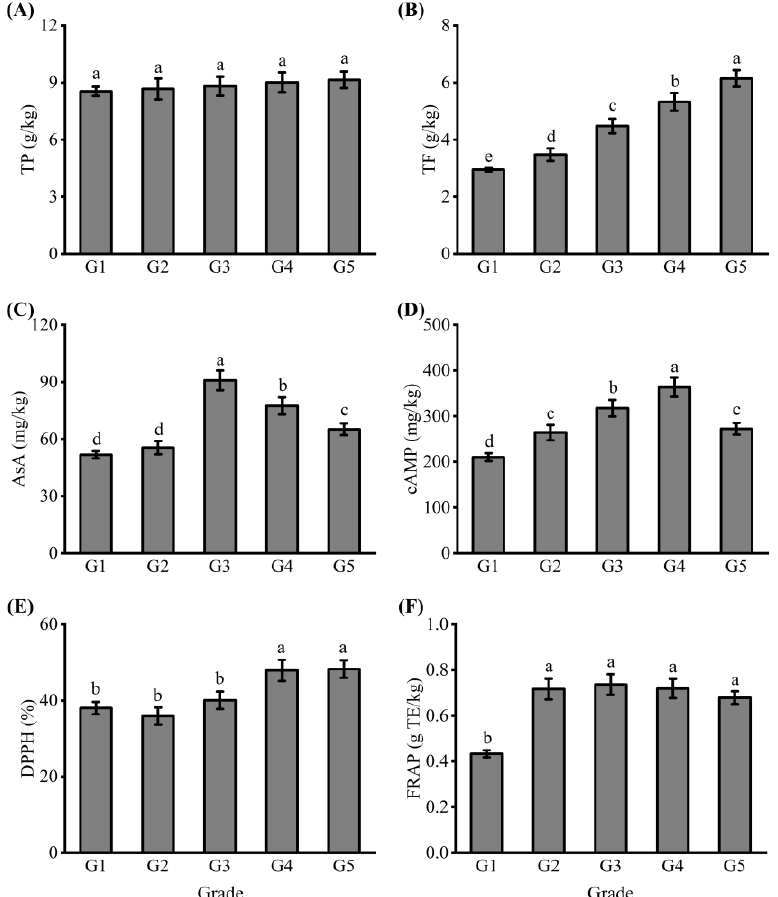
Figure 2. The contents of ( A ) total phenolics (TP), ( B ) total flavonoids (TF), ( C ) ascorbic acid (AsA), ( D ) cyclic adenosine monophosphate (cAMP), ( E ) 2,2-diphenyl picrylhydrazyl (DPPH) radical scav- enging activity, and ( F ) ferric reducing antioxidant power (FRAP) of dried jujube. The dried jujube were arranged in the order from large to small, which were G1, G2, G3, G4, and G5 groups, respec- tively. Data are expressed as means ± standard deviation (SD) from three replications. Means with different letters are significantly different ( p < 0.05).